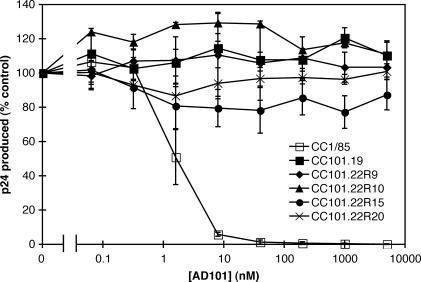
AD101 Sensitivity of AD101-Resistant Isolates after Extensive Passage in the Absence of AD101PBMC cultures were infected with the parental isolate CC1/85 (open squares), the resistant isolate CC101.19 (filled squares), or isolates CC101.22R9 (filled diamonds), CC101.22R10 (filled triangles), CC101.22R15 (filled circles), and CC101.22R20 (X symbol) from the reversion cultures, in the presence of different concentrations of AD101. The amount of p24 produced in each AD101-containing culture after 7 d is shown as a percentage of that produced by the same isolate in the absence of inhibitor. The values shown are the means of four independent experiments ± SEM.